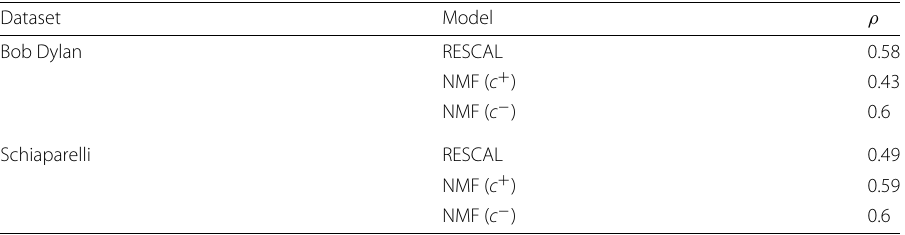
Table 3 Correlations between the average edge weight between node classes and estimated node class interdependencies using different models